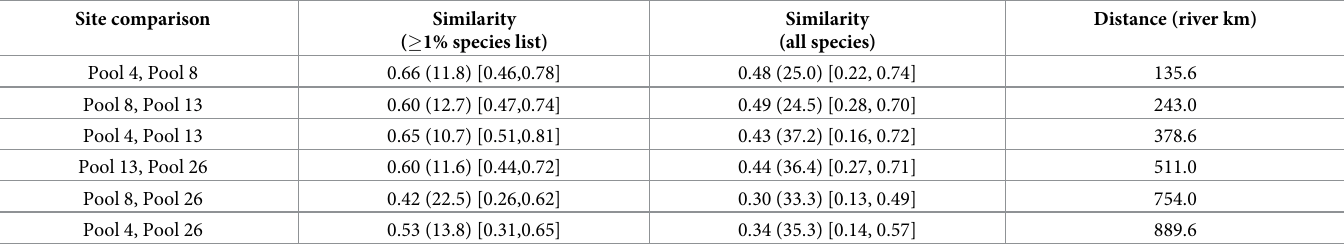
Table 1. Average of the Bray-Curtis similarity index from 1993–2014 between pools in the upper Mississippi River. The coefficient of variation is given in parentheses and the range is in brackets. Distance is from the middle of each pool (by river kilometers).